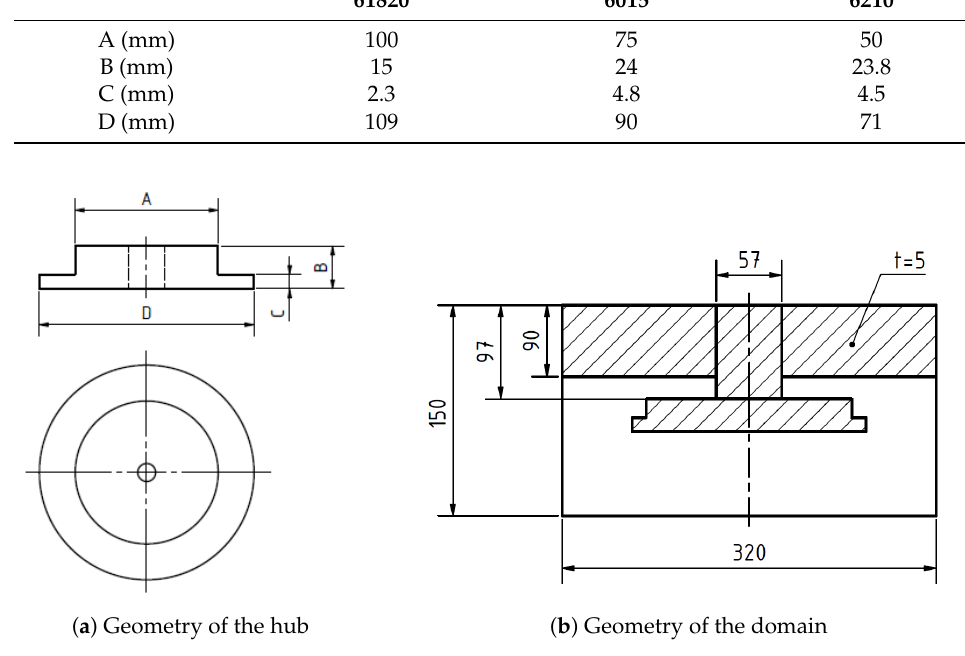
Figure 5. Geometry of the hub and computational